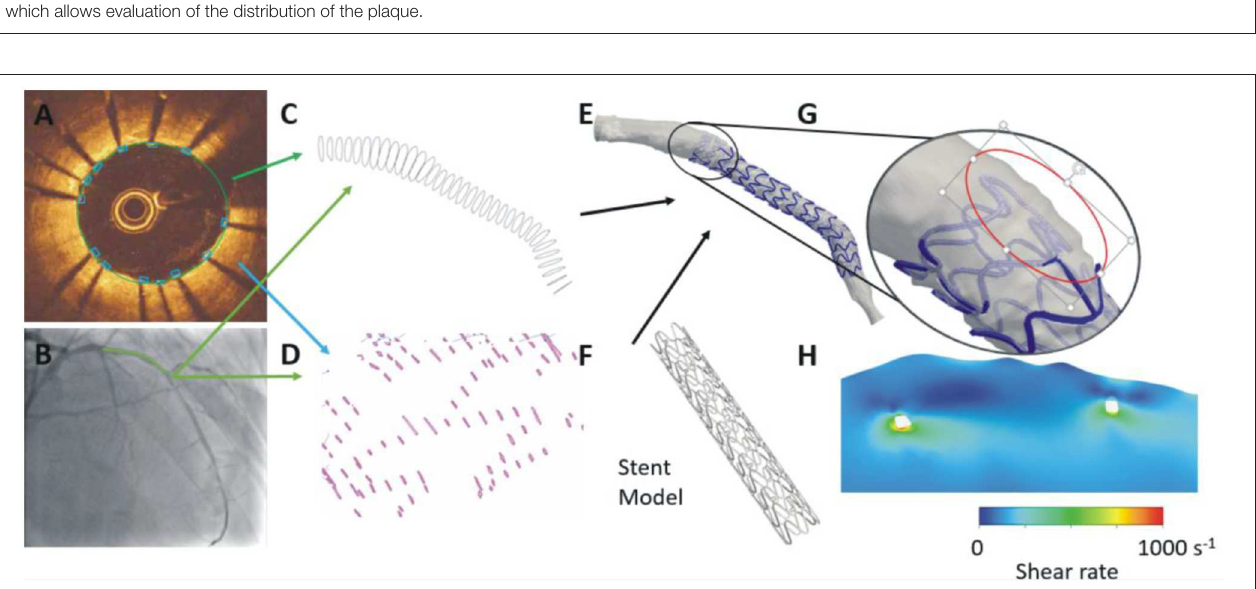
FIGURE 5 | path from two angiographic projections. Finally, (C,D) show the platform designed for the visualization of the 3D model. The operator can appreciate the lumen geometry (C) , assess plaque distribution portrayed in a color-coded map (blue indicates no plaque and red indicates increased plaque burden) and assess the lumen morphology from inside (D) . (E–H) portray snapshots of the IVUSAngio tool. (E) shows the module for IVUS analysis, (F) the tool designed for the catheter path extraction, (G) illustrates the 3D model with the media-adventitia shown in a semi-transparent fashion, enabling evaluation of the distribution of the plaque burden and (H) portrays an endoscopic view of the lumen morphology. Finally, (I,J) illustrate snapshots of the software designed by Leiden University for the reconstruction of coronary artery anatomy. The annotated intravascular imaging data and the 3D-QCA model are imported and fused. The operator can identify in the lumen centerline the location of frames portraying side branches and use these to estimate their rotational orientation (I) . The reconstructed lumen is then fused with the side branch model obtained by 3D-QCA to generate the final vessel geometry. (J) shows the reconstructed vessel; the outer vessel wall is shown in a semi-transparent fashion, which allows evaluation of the distribution of the plaque.